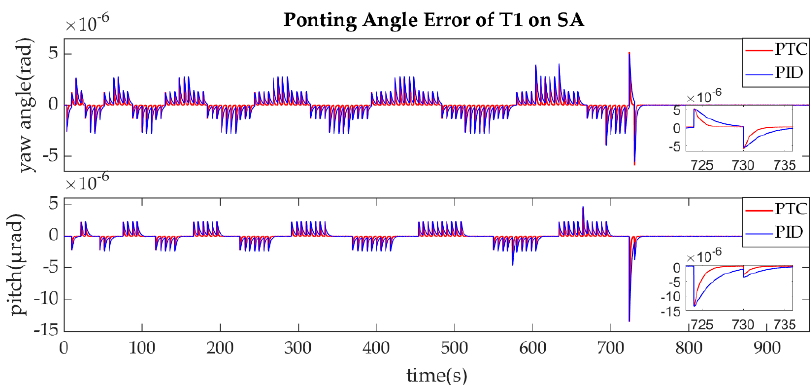
Figure 23. Comparison for the Pointing Angle Error of T1 on SA.